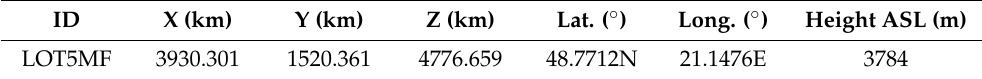
Table 2. Initial coordinates in JTSK. Table 3. The initial position of FO was obtained by calculation according to derived